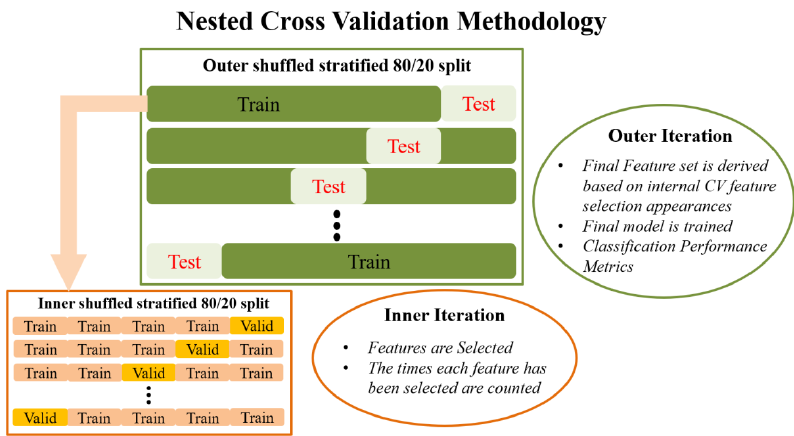
Figure 1. Graphical representation of the cross validation pipeline.